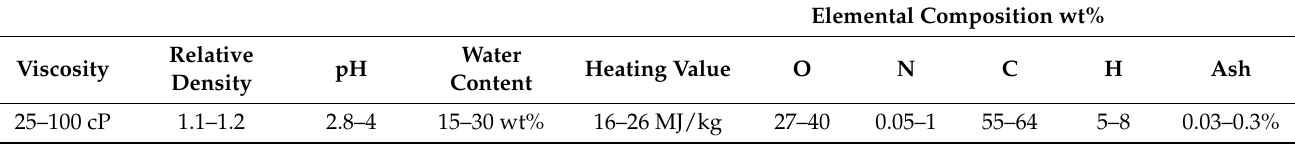
Table 4. Summary of typical bio-oil characteristics. Adapted from